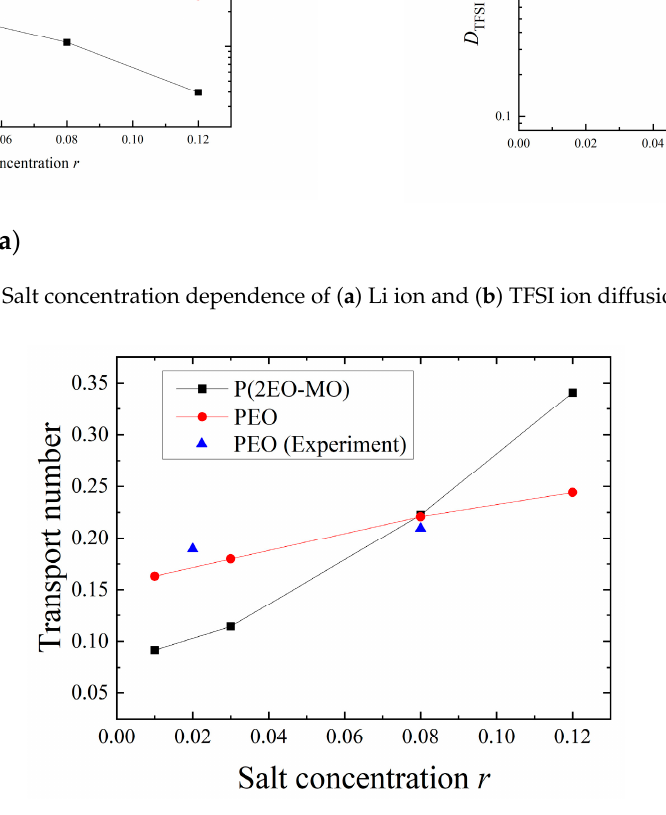
Figure 8. Salt concentration dependence of transport number. Experimental data were taken from Timachova et al. [23].